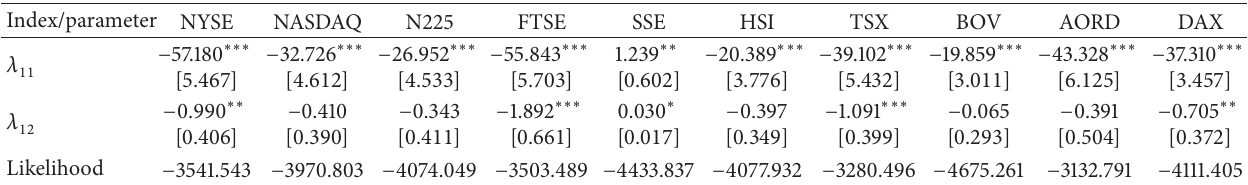
Table 8: Results of TVRAS-GARCH-M model (MAX).